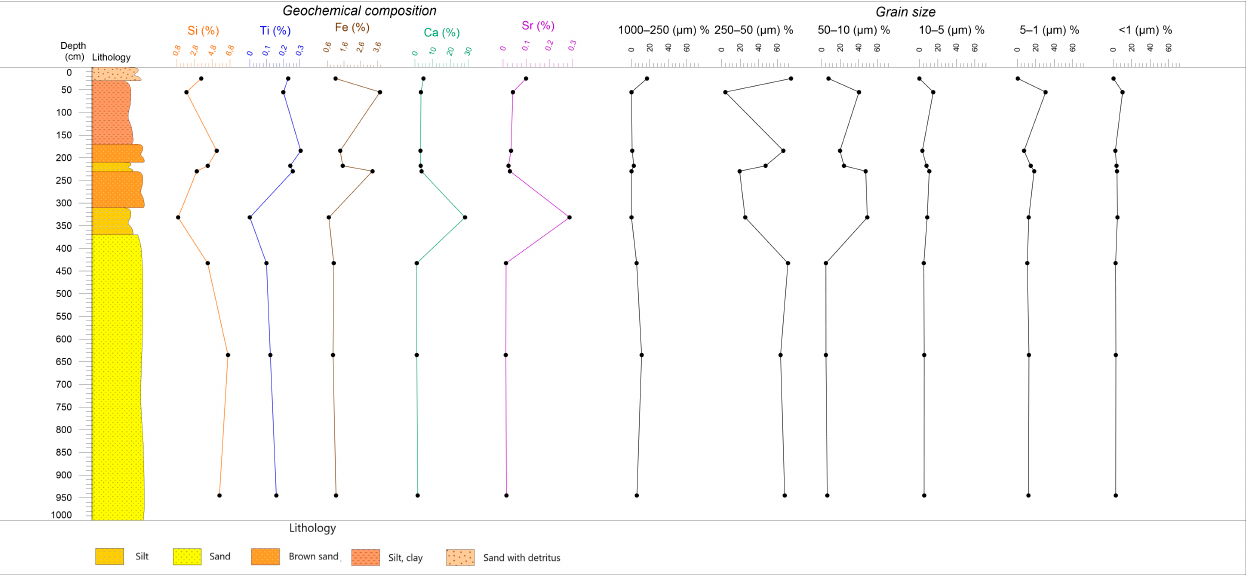
Figure 2. Grain size and geochemical analysis results of the studied Rybachya core.